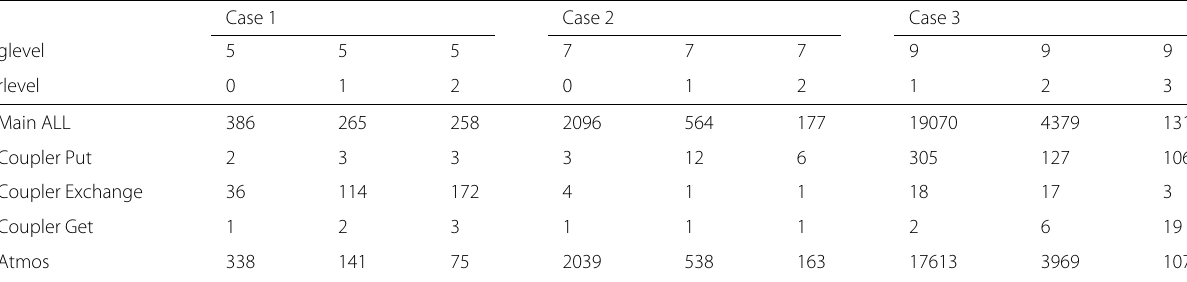
Table 8 Execution time of NICAM